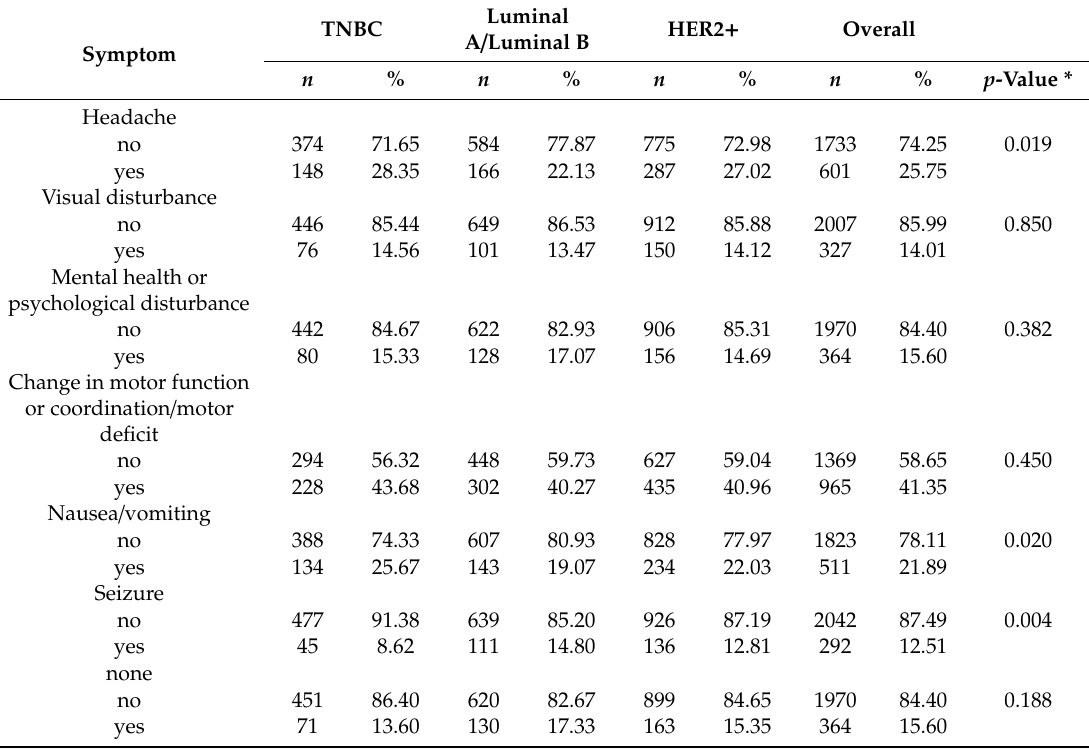
Table 6. Distribution of the neurological symptoms according to the biological